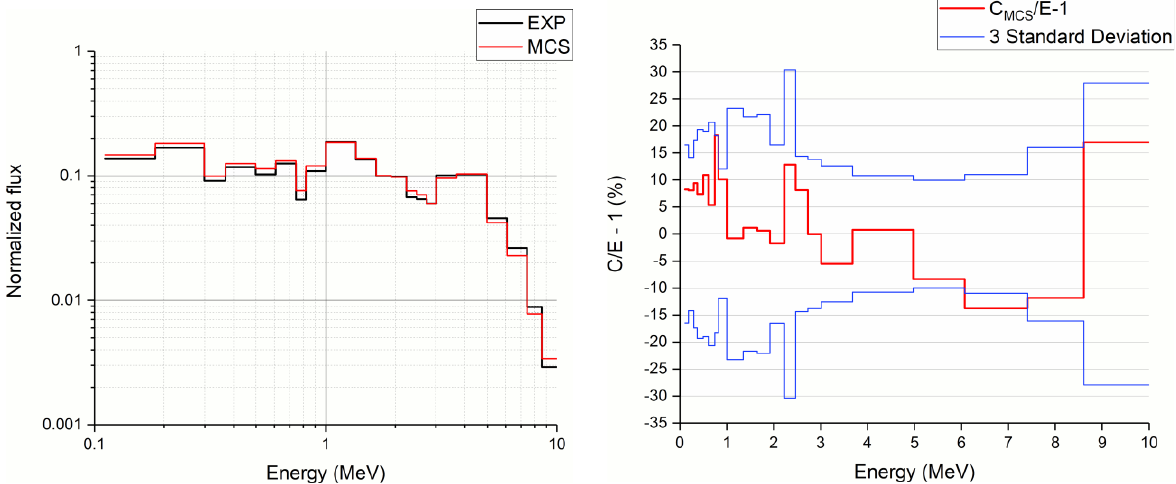
Figure 7. Comparison between MCS calculation and measurement of the neutron spectrum inside of the core in terms of relative units (left) and C/E – 1